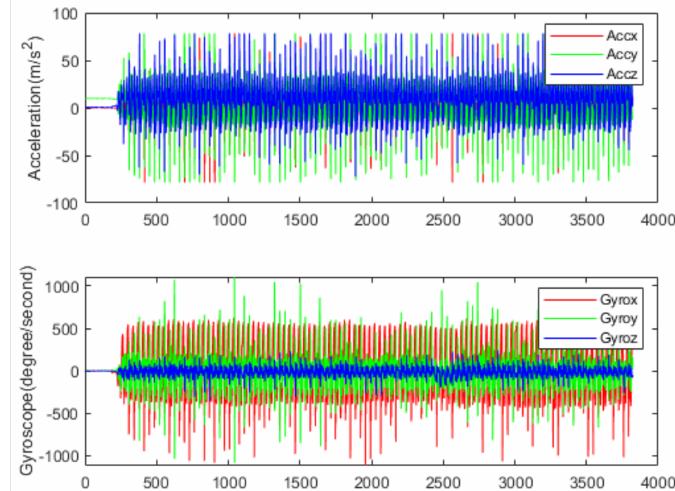
Figure 6. Data collected by accelerometer and gyroscope on running.